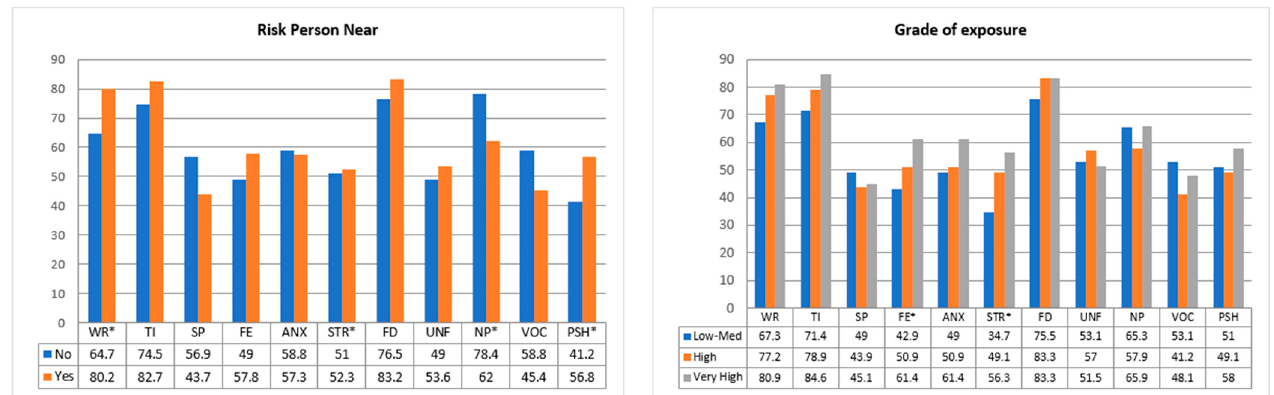
Figure 2. Association between psychological variables and nurses’ characteristics. WR (worried), TI (tired), SP (sleep problems), FE (fear), ANX (anxiety), STR (stress), FD (felt down), UNF (unfocused), NP (negative performance), VOC (vocation), PSH (psychological help); * significant value.